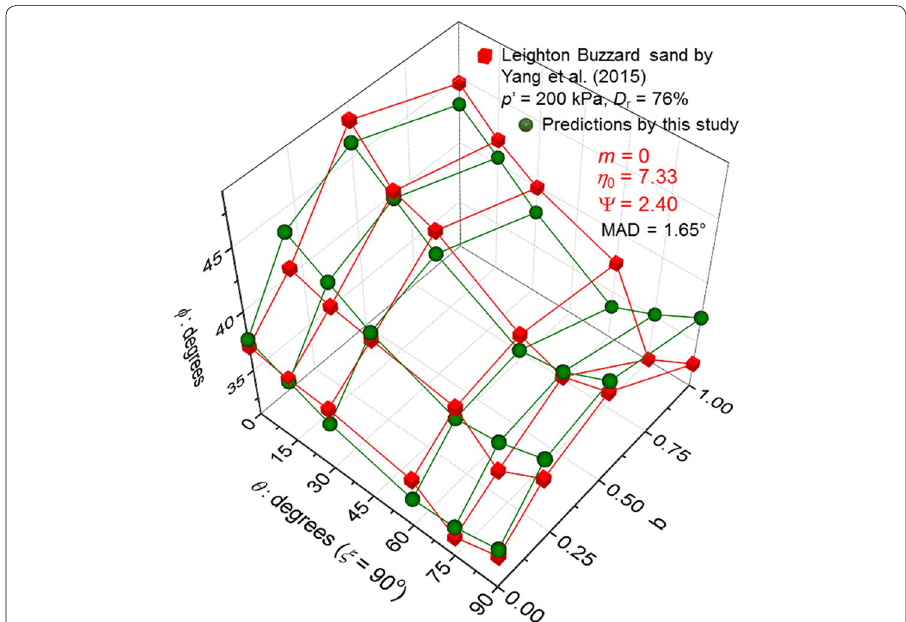
Fig. 13 Comparison between torsion shear test results of Leighton Buzzard sand by Yang et al. [16] and predictions by this